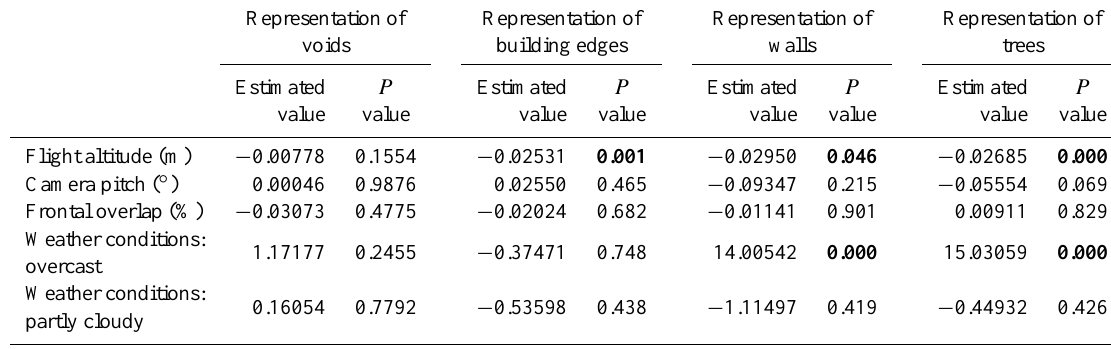
Table 4. Results of the statistical models for the qualitative metrics. Bold figures represent P values below 0.05.